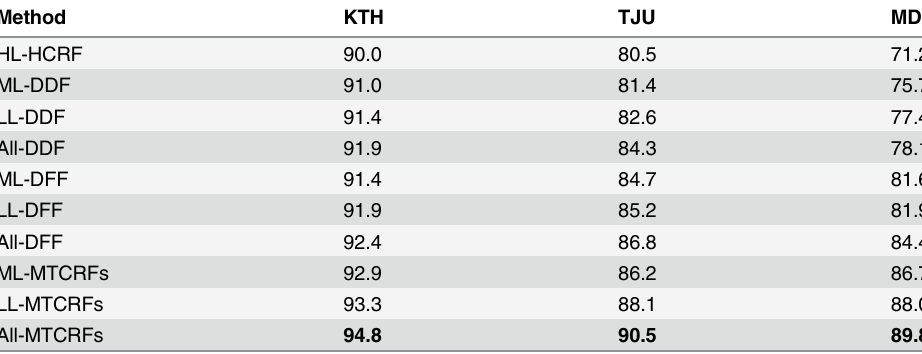
Table 1. Performance Comparison on KTH, TJU, and MDA